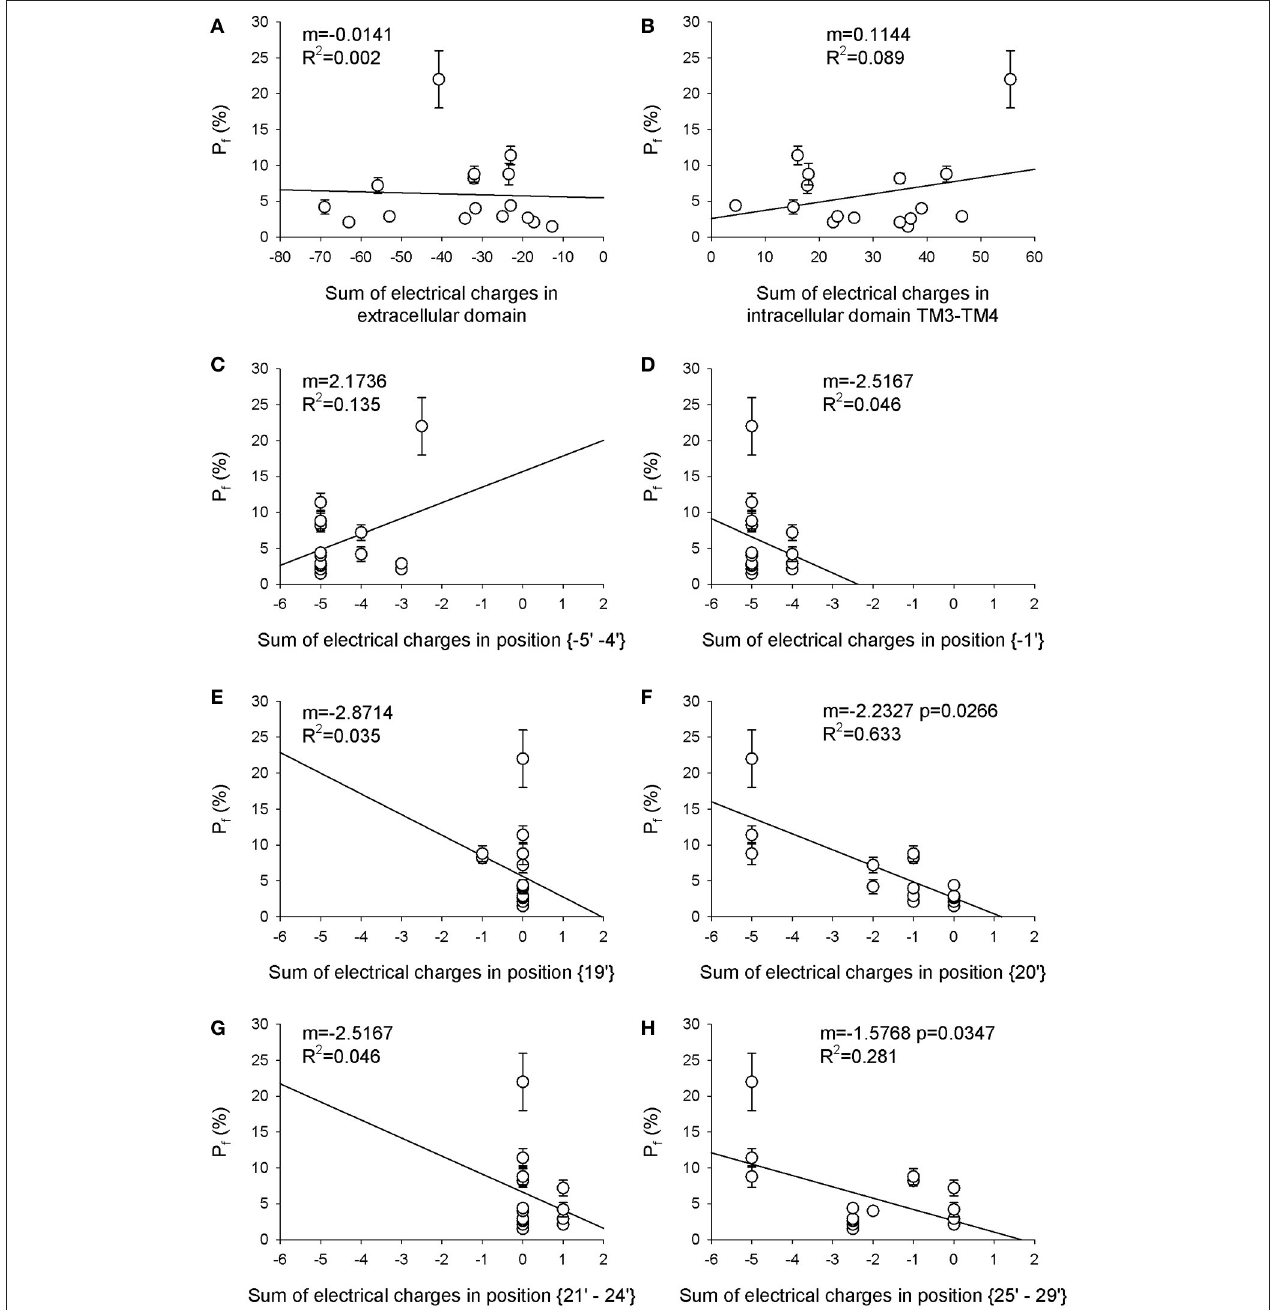
FIGURE 1 | Electrical charge in the TM2 extracellular ring (position 20 ′ ) is the main determinant of Ca 2 + permeability. The sum of the electrical charges associated with charged amino acids in eight different regions of each nAChR reported in Table 1 has been calculated and plotted against the Pf -value of the same nAChR. (A) extracellular domain; (B) intracellular domain between TM3 and TM4; (C) position { − 5 ′ − 4 ′ } (where 0 ′ is the conserved lysine residue immediately preceding TM2, according to Miller, 1989); (D) position { − 1 ′ }; (E) position {19 ′ }; (F) position {20 ′ }; (G) position {21 ′ –24 ′ }, (H) position {25 ′ –29 ′ }. In each panel the angular coefficient m of the linear regression is reported, expressed in nuec − 1 , as well as the R 2 -value, to evaluate the fit. Please note the significant linear correlations reported in (F) for position {20 ′ }, and in (H) for position {25 ′ –29 ′ }, with the indicated p -values.